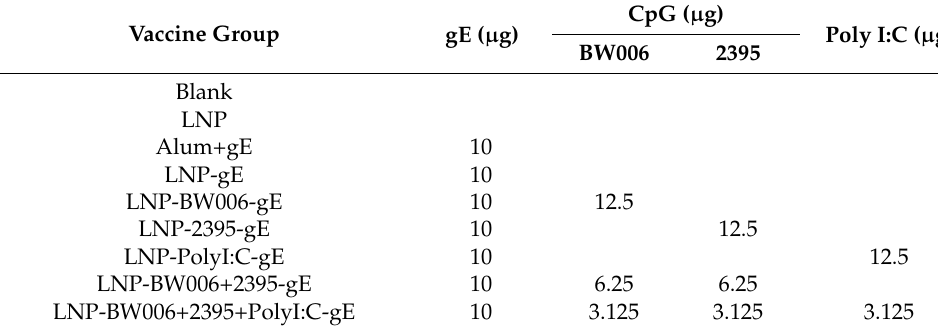
Table 1. Designed vaccine composition of each